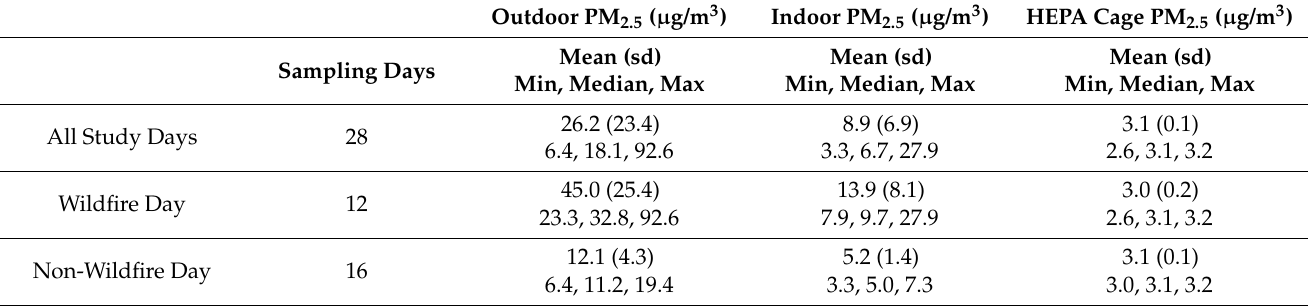
Table 1. Outdoor, indoor, and HEPA cage PM 2.5 concentrations from 8 August–4 September